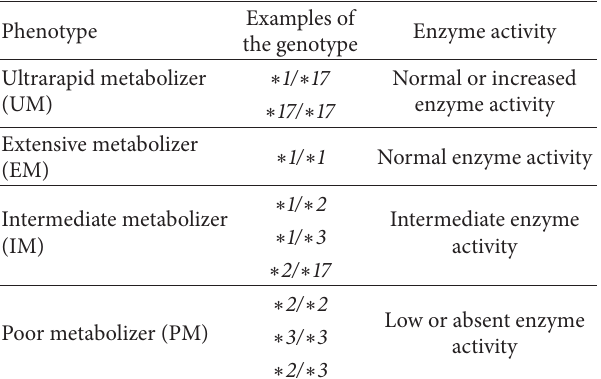
Table 1: Phenotype metabolising classes based on CYP2C19 genotype ∗